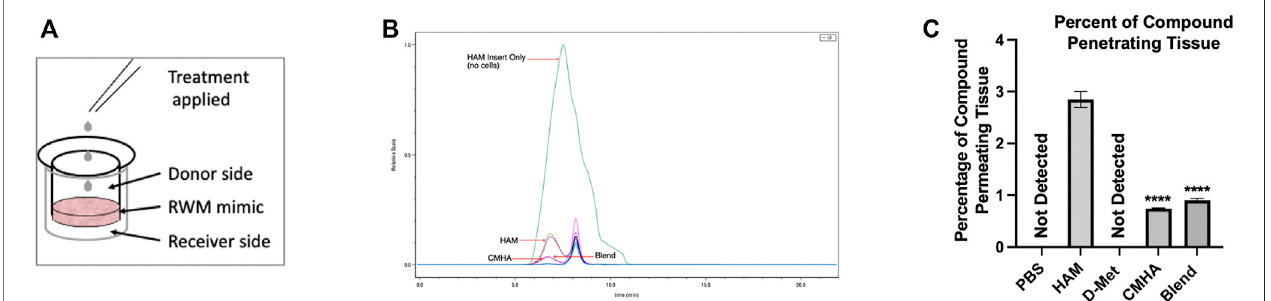
FIGURE8| InvestigationofthetransmembranepermeationabilityofHAM. (A) Illustrationofthepermeationexperimentsetup. (B) ChromatogramofSECanalyzed samples detected with an RI detector. The teal (largest) curve corresponds to HAM passed through a blank/no tissue insert. The mustard green and purple traces correspondtoHAMpassedthroughinsertswithEpi-Airwaytissuesasroundwindowmembrane(RWM)models.Themagentatracecorrespondstotheblendtreatment passed through an insert with Epi-Airway, and the dark purple trace corresponds to CMHA passed through an insert with Epi-Airway. (C) Quanti fi cation of the amount of HAM or controls detected after permeation of Epi-Airway tissues. Data presented are mean ± SD. One-way ANOVA with Tukey ’ s multiple comparisons run. ANOVA results compared to HAM group: CMHA p < 0.0001 and blend p < 0.0001.